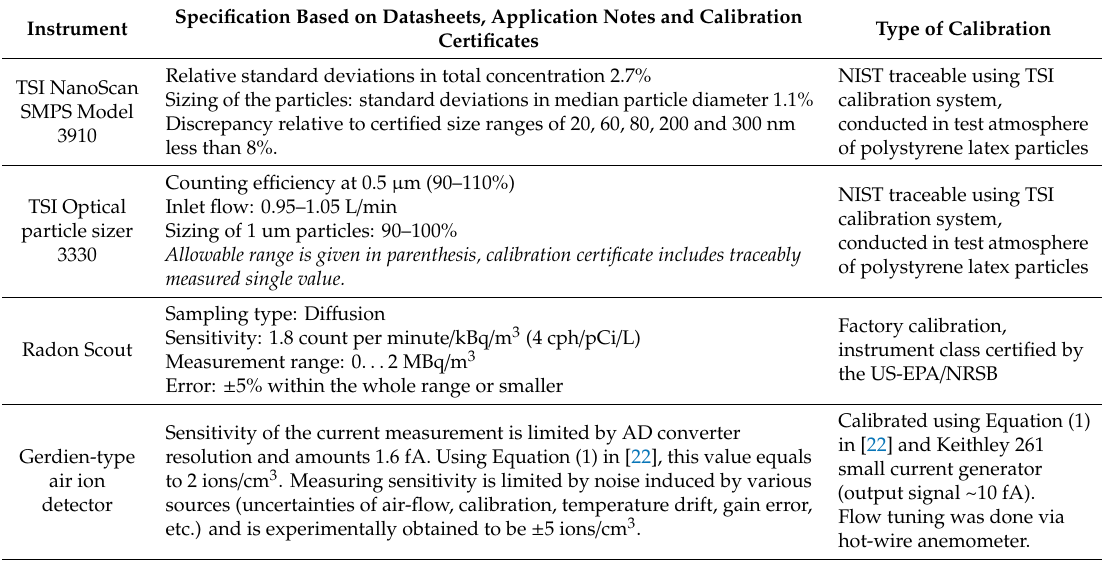
Table A1. Description of the instruments used in data gathering campaigns conducted in this